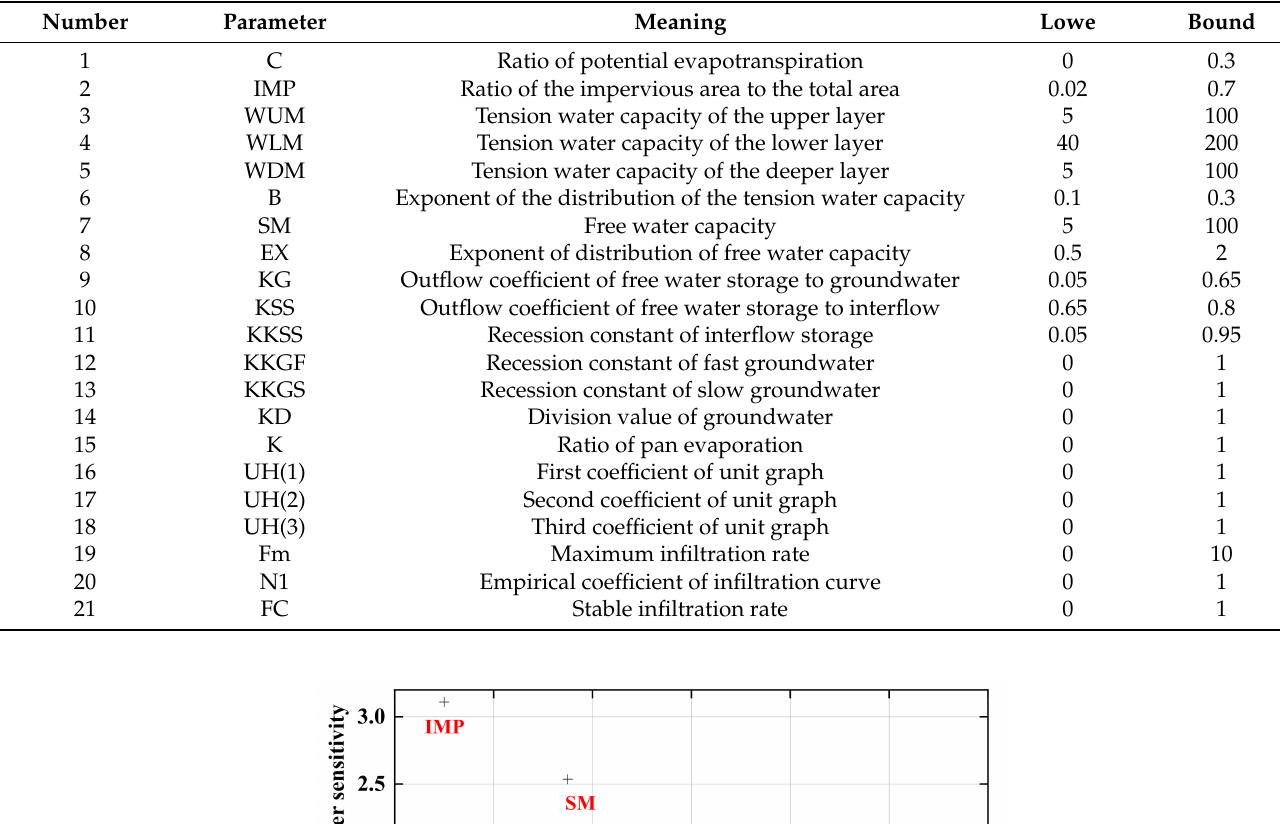
Table 1. Model parameters and associated ranges.